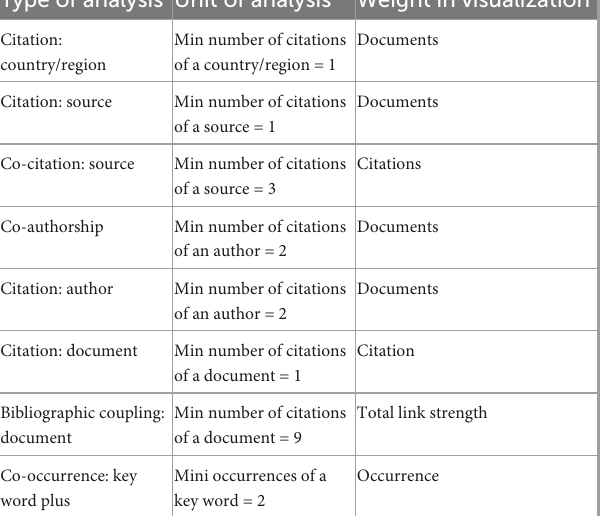
TABLE 1 Threshold and visualization for each type of analysis in VOSviewer